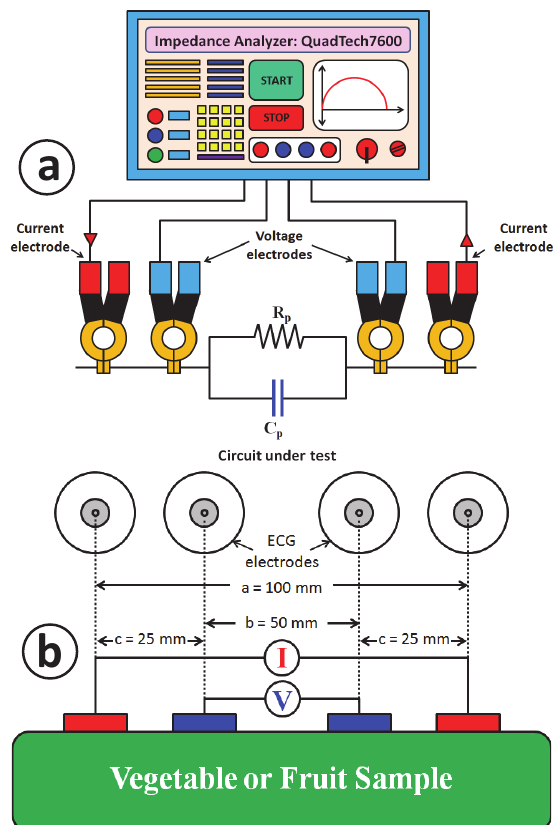
Fig.7: EIS data collection with the four-probe method using an impedance analyzer. (a) A schematic of the electronic circuit elements in the EIS data collection using the QuadTech7600 impedance analyzer. (b) A schematic of EIS data collection from fruit and vegetable tissues.